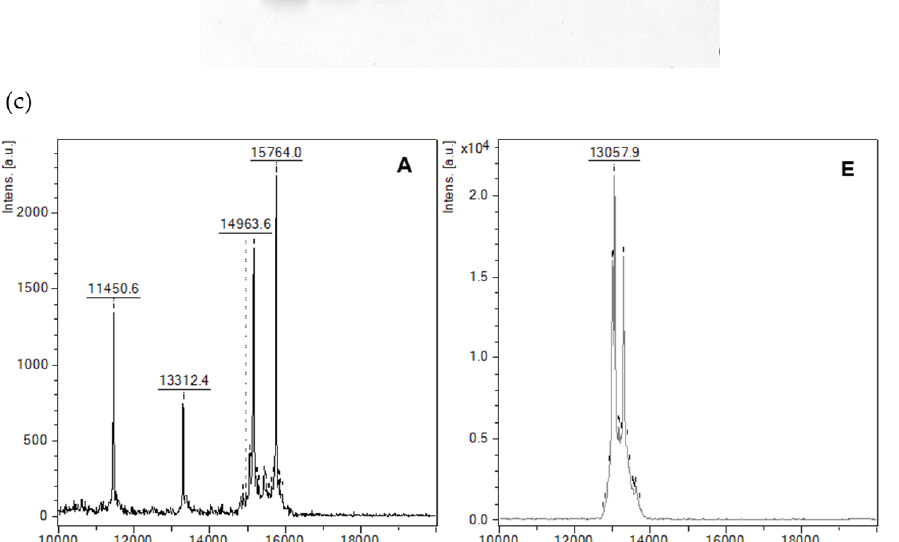
Figure 3. HPLC fractionation ( a ), SDS-PAGE ( b ) and MALDI TOF MS ( c ) of extracted ATIs from Ponticus .